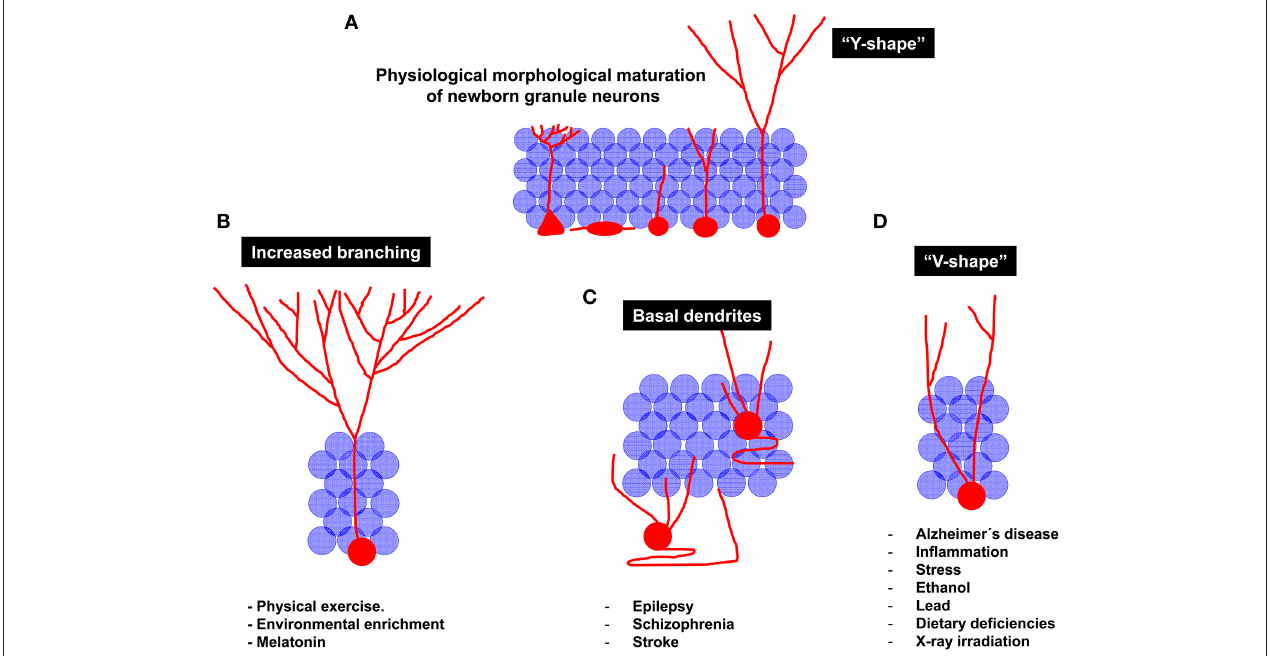
FIGURE 4 | Schematic diagram of the regulation of newborn granule neuron morphological maturation under physiological and pathological conditions. (A) Morphological maturation under physiological conditions. It should be noted that, at the end of the maturational process, newborn neurons generally acquire a “Y-shape,” displaying one single primary apical dendrite emerging from the soma. The high dendritic branching observed in the molecular layer lead them to resemble to the aforementioned “Y” shape. (B) Neuroprotective stimuli are considered stimulators of newborn neuron maturation. For instance, physical exercise and Environmental enrichment increase dendritic branching of newborn granule neurons. (C) Pathological maturation of newborn neurons occurs in epilepsy, schizophrenia and stroke. Under these circumstances, newborn neurons are aberrantly located in the Hilus or in deeper layers of the Granule layer. In addition, recurrent basal dendrites are commonly observed. (D) Other pathological circumstances, including neurodegenerative disorders, inflammation, stress, alcohol consumption, dietary deficiencies, lead exposure, or X-ray irradiation result in impaired maturation of newborn neurons. Interestingly, a reduced branching in the molecular layer and the presence of several apical dendrites emerging from the cell soma are observed in these pathological circumstances. These morphological features lead granule neurons to acquire a “V-shape,” in contrast to the “Y-shape” displayed by them under physiological conditions.